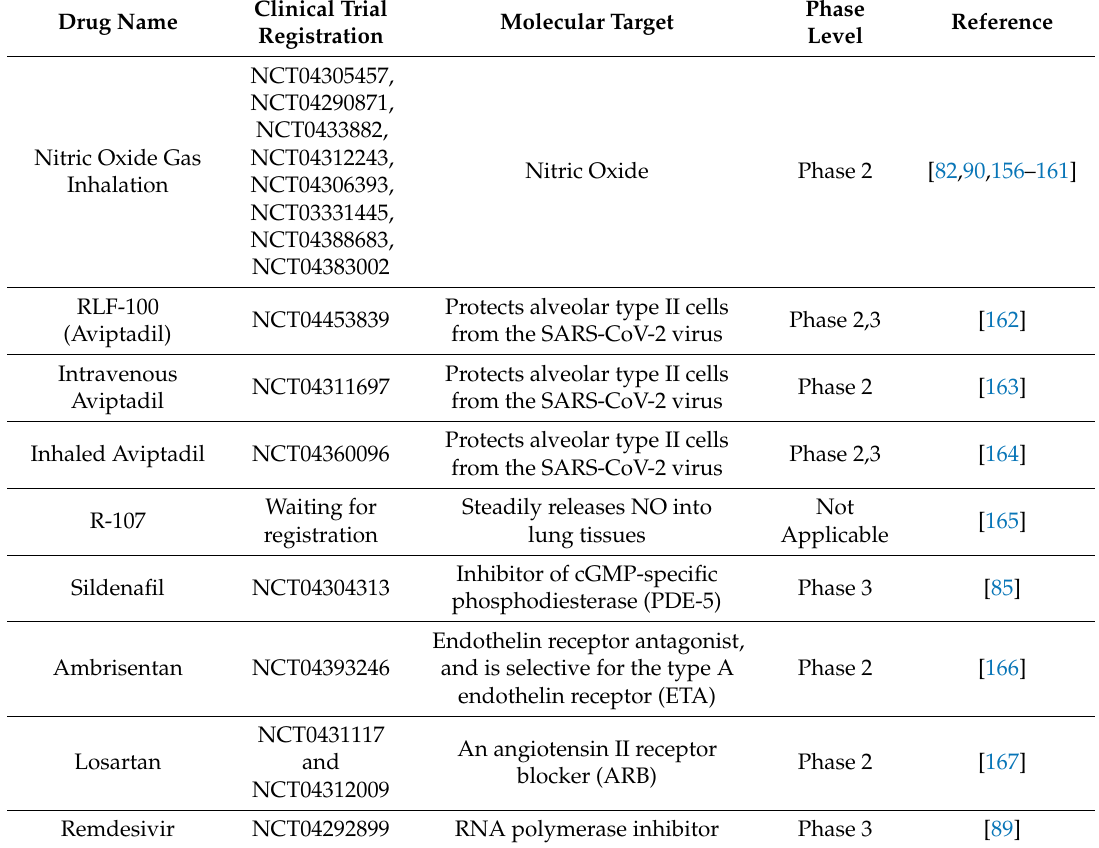
Table 1. Clinical trials on COVID-19 that can impact pulmonary